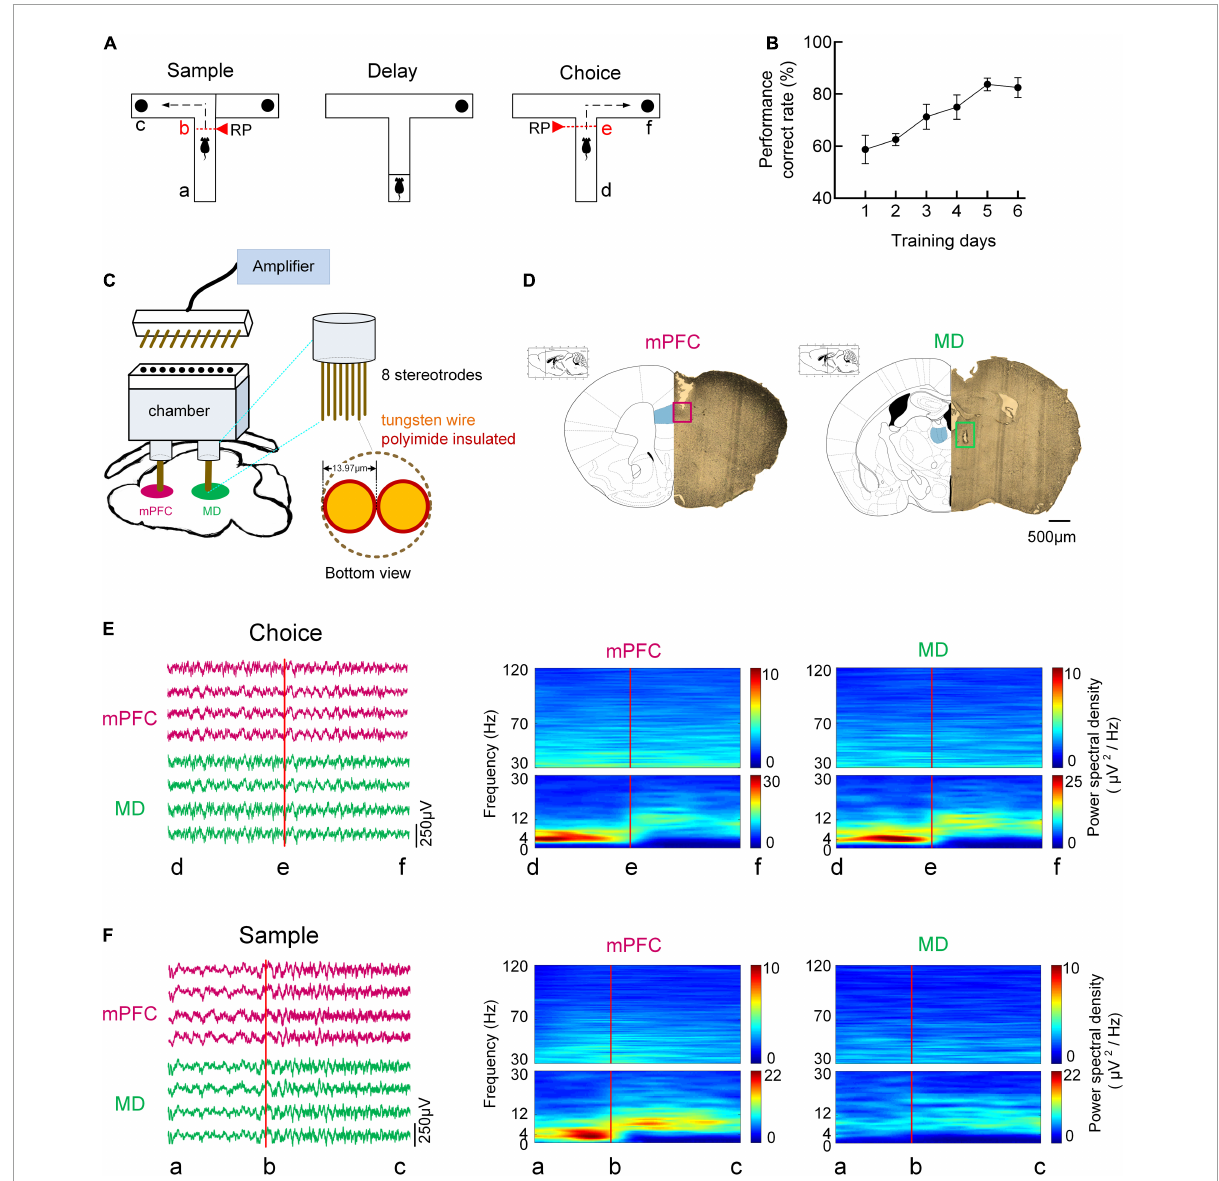
FIGURE1 Behavioral task and oscillatory dynamics in mPFC and MD during the task. (A) Schema of a single trial of the DNMTP task in T-maze. In the sample/choice phase, the mouse’s initial position was defined as the point a/d, and the turn began was denoted as the point b/e, and the reward position was denoted as the point c/f. (B) Behavioral performance. The percentage of correct goal choice was enhanced as training progressed n = 8 mice. Error bars represent mean ± SEM. (C) Diagram for simultaneous multi-channel microelectrode recording. (D) Histological verification of the recording sites in the mPFC, PrL region (left) and MD (right). The partial brain sections show the typical recording sites (marked by rectangle) in the two regions. The superimposed schematics adapted from Paxinos and Charles (2005) show the coronal brain sections at 1.78 mm anterior and 1.22 mm posterior to the bregma. Scale bar, 500 µ m. (E) Time-frequency power spectrum of LFPs during the choice phase on correct trials. (Left) Example single-trial LFP traces recorded from mPFC (purple) and MD (green). (Right) LFP power spectrum cross correct trials in mPFC and MD for a single mouse. (F) Same as (E) , but for sample phase.